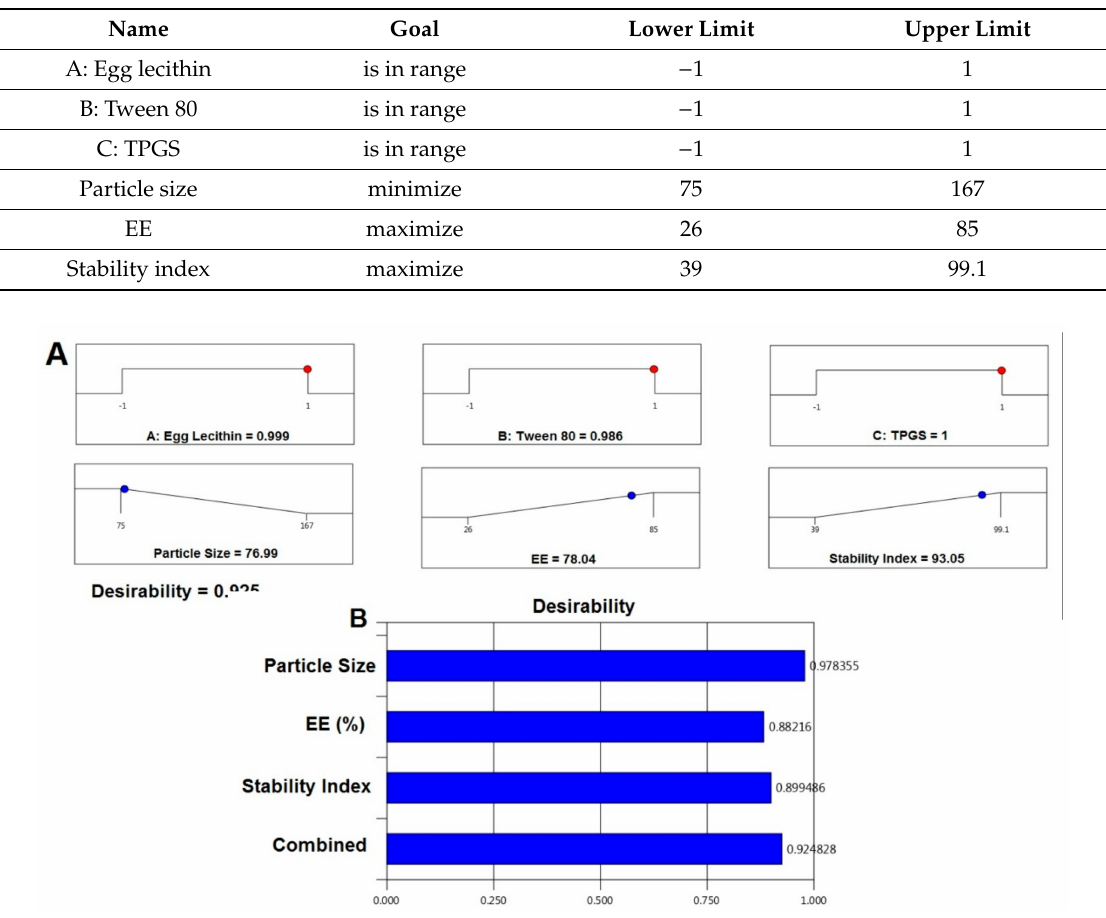
Table 5. Criteria for the selection of optimized formulation.